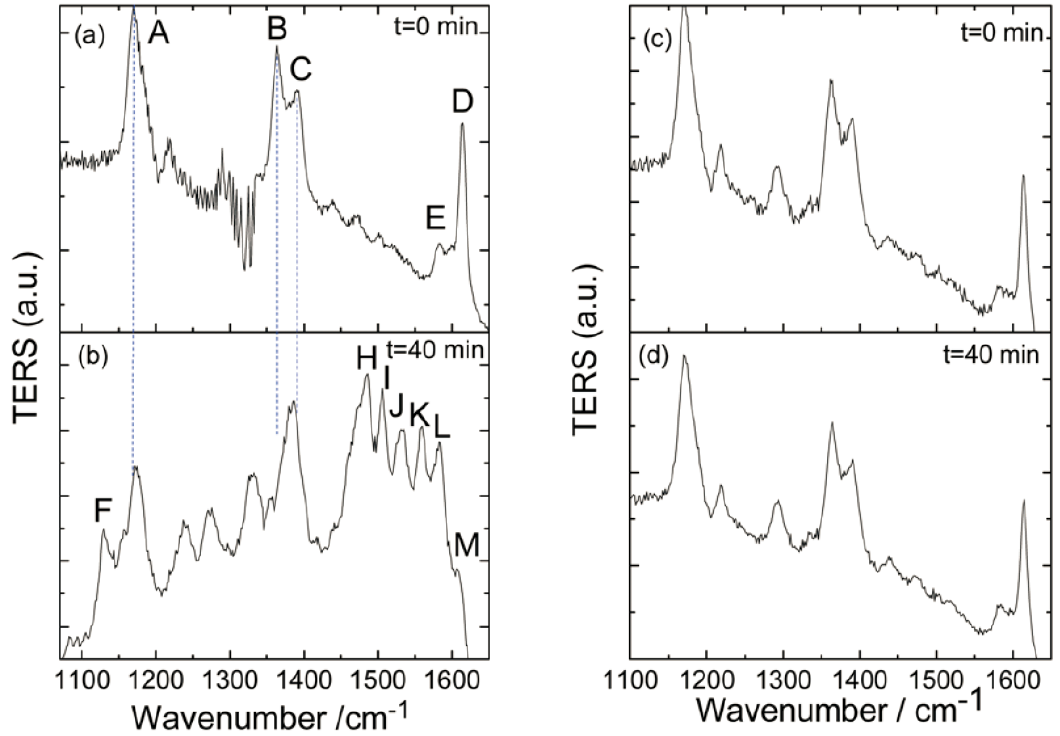
Figure 6. TERRS of MG adsorbed on the Ag film at t = 0 and t = 40 min. ( a , b ) Sample irradiated with 10% lower laser power compared to the sample analyzed in Figure 3a,c shows evidence of a slower dissociation rate; ( c , d ) without continuous laser irradiation of the sample shows that the tunneling current alone is not sufficient to induce dissociation. Adapted from [9].